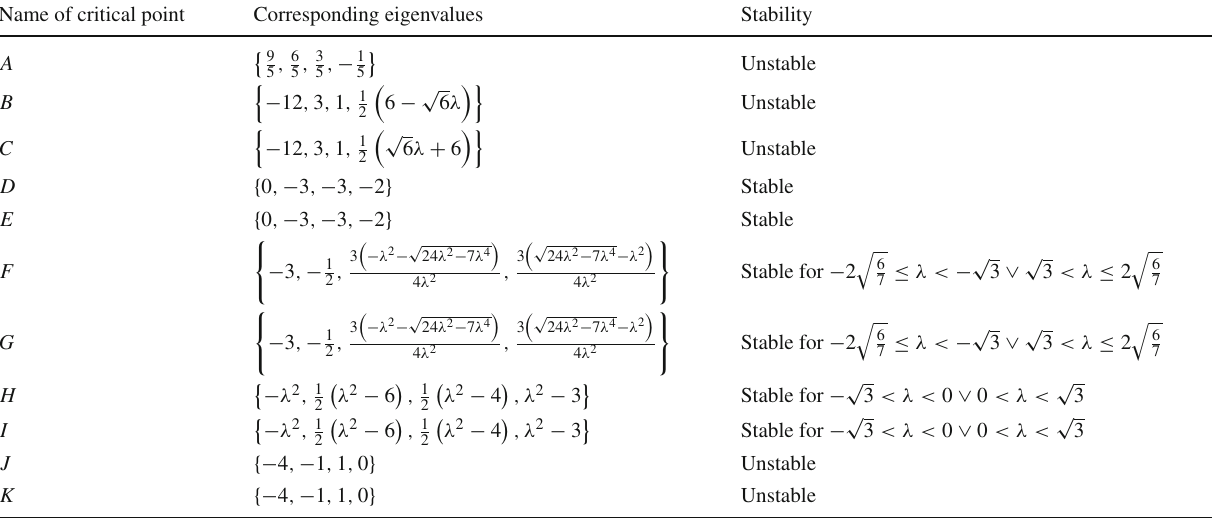
Table 10 Eigenvalues and stability of eigenvalue at corresponding critical point Name of critical point Corresponding eigenvalues